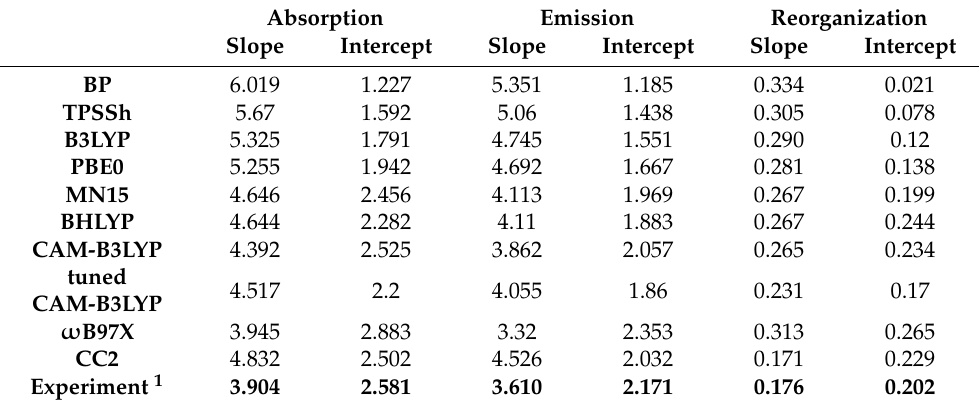
Table 4. Parameters of the linear functions of 1/ n fitted to the calculated and experimental values of the electronic transition energies, and the reorganization energies for the studied oligofurans.